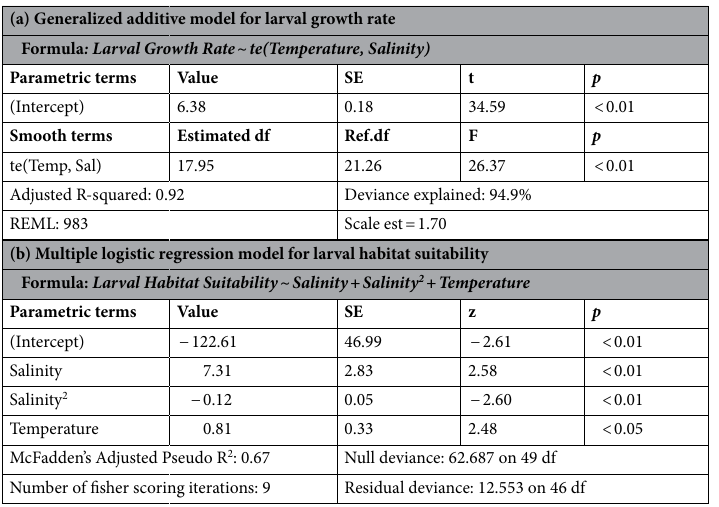
Table 1. Model summaries for larval growth rate and larval habitat suitability models. Model summary of Generalized Additive Model for larval growth using a full tensor product smoother (a) and Multiple Logistic Regression Model of larval habitat suitability using temperature and salinity as predictor variables